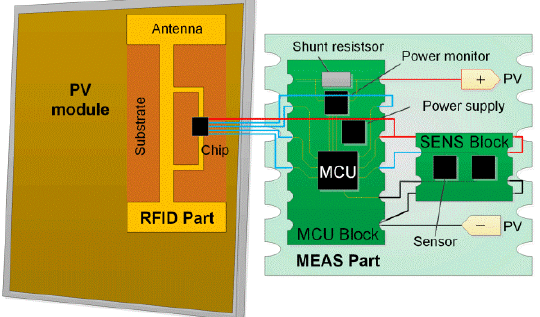
Figure 4. Block diagram of the RFID transponder-sensor.